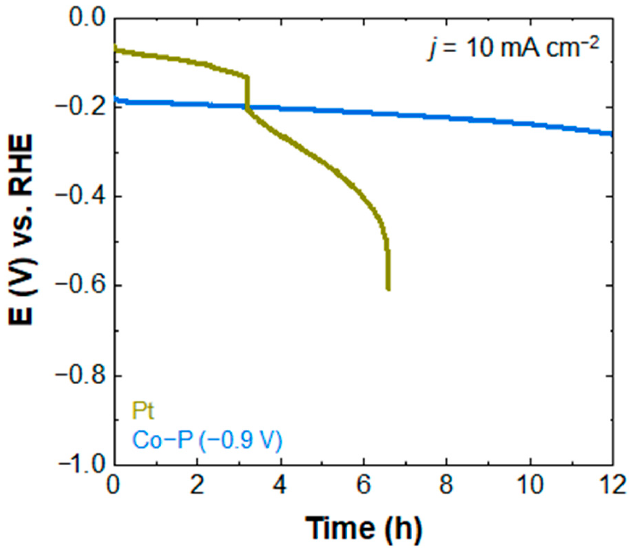
Figure 6. Chronopotentiometry curves of Co-P electrodeposited at − 0.9 V, and Pt on ITO substrate at a current density of 10 mA cm − 2 .